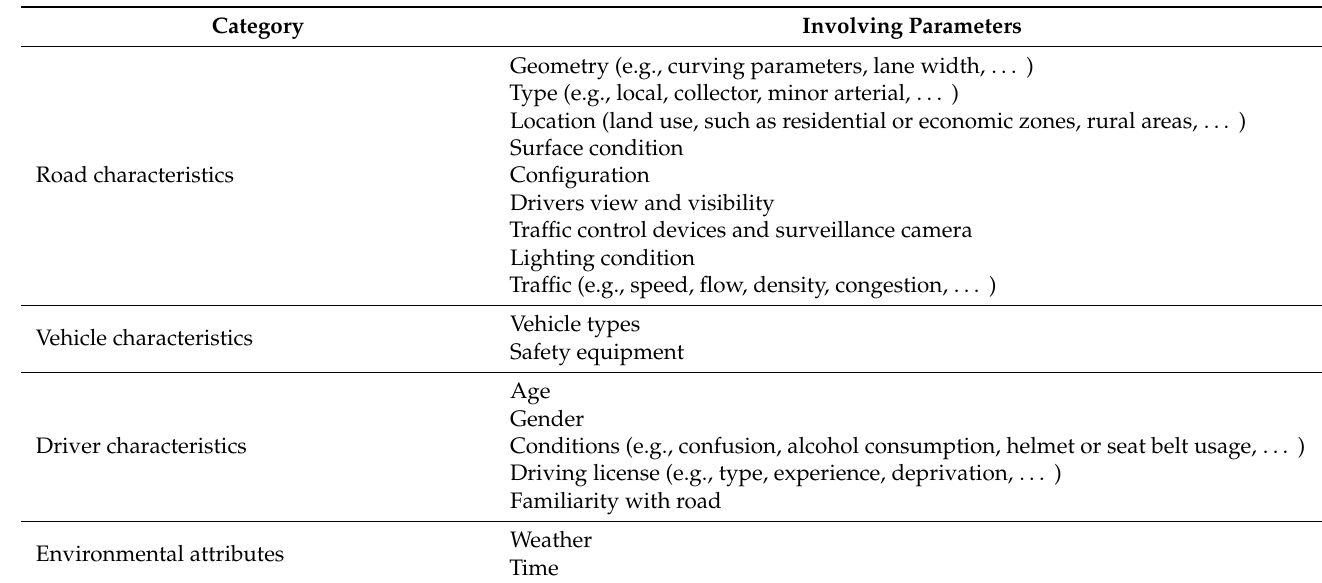
Table 1. Factors affecting road